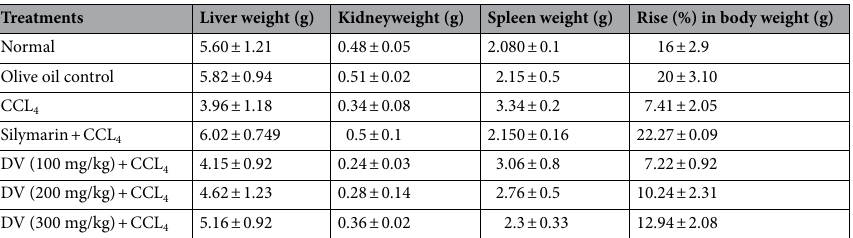
Table 2. Protective effect of chloroform extract of Dodonaea Viscosa flowers. All the values are obtained in triplicate (mean ± standard deviation).